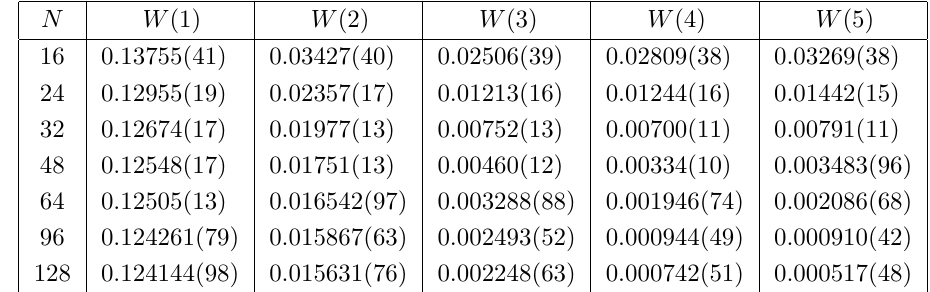
Table 9. Wilson loop for L = 1 , 2 , 3 , 4 , 5 , unconstrained, n t = 24 , T = 0 . 25 .